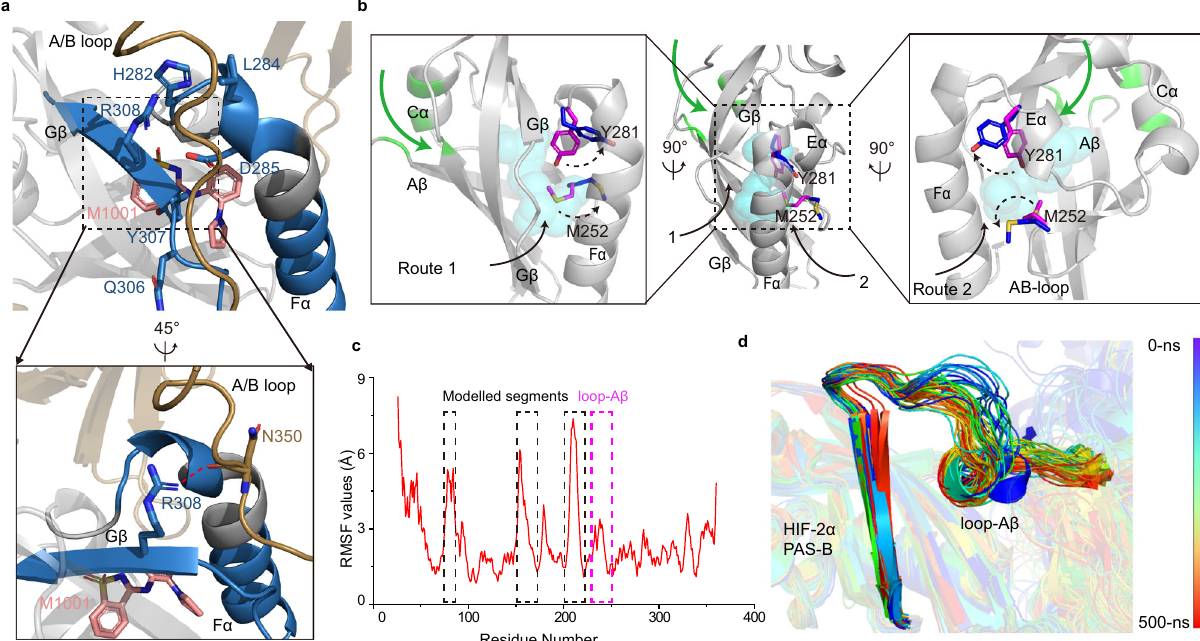
Fig. 5 A possible common mechanism in ligand binding shared by HIF-2 α . a The residues of F α and G β with reduced deuteration levels are mapped on the crystal structure in blue, and the R308 in G β of HIF-2 α forms a hydrogen bond with the A/B loop of ARNT. Hydrogen bonds are shown in red dotted lines. b Two routes previously proposed for ligands to enter or leave the HIF-2 α PAS-B pocket are indicated by black arrows, and enlarged views of two routes are shown on the left and right sides, respectively. The possible new entry route of ligands into HIF-2 α , corresponding to that of OEA into HIF-3 α , is shown by a green arrow, with the residues surrounding the entrance also colored green. M252 and Y281 are shown in magenta in the apo structure, and blue in co-crystal structures. M252 and Y281 were fl ipped outwards (as shown by dotted arrows) by antagonist PT2385 and agonist M1001, respectively. The PDB codes of HIF-2 α -ARNT-PT2385 and HIF-2 α -ARNT-M1001 are 6E3S and 6E3U. c C α RMSF plots for HIF-2 α in a monomeric system. The highly fl exible regions including modelled linkers (black) and loop-A β (magenta) are highlighted. d The conformational change of the loop-A β region in snapshot structures extracted from the trajectories of HIF-2 α during the MD